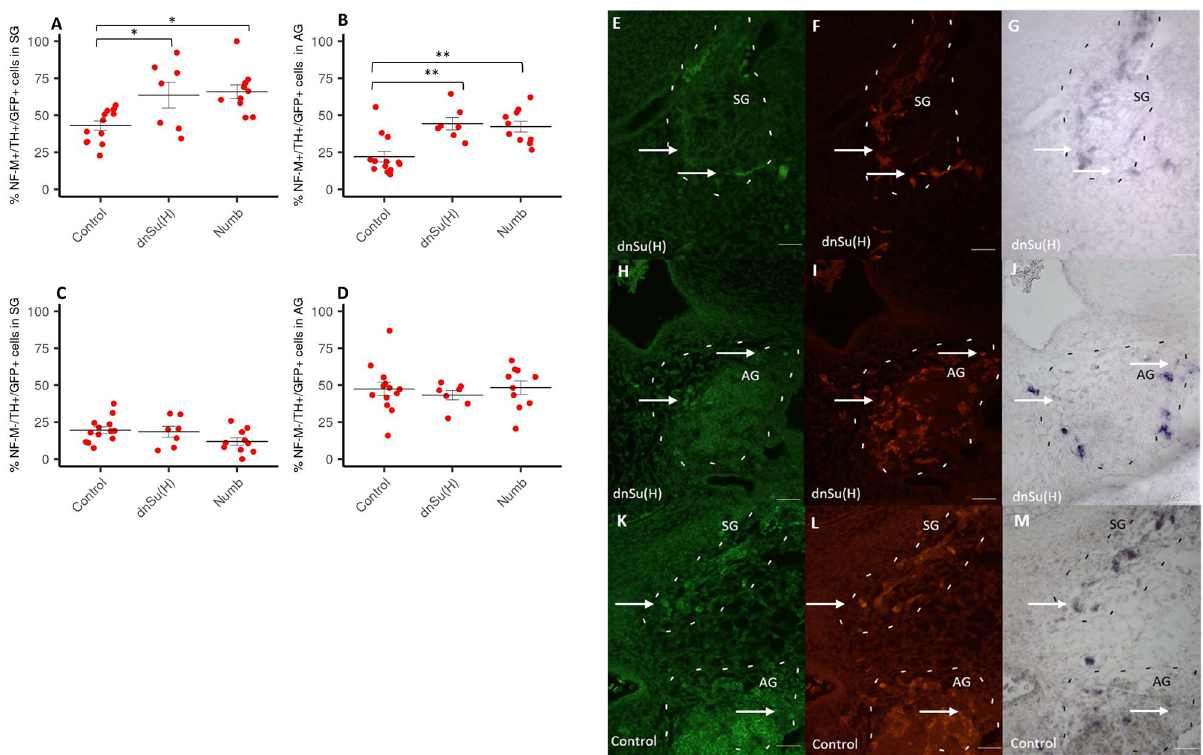
Fig 3. Analysis of neuronal and nonneuronal cells in SG and AG following downregulation of Notch. Amount of NF-M+/TH+/GFP+ cells in SG (A) and AG (B), and amount of NF-M-/TH+/GFP+ cells in SG (C) and AG (D) of E6 chick embryos after electroporation with dnSu(H) or Numb at E2 (control n = 13, dnSu(H) n = 7, Numb n = 10). Data are presented as mean +/- S.EM. and expressed as percentage of the total number GFP+ cells. � p � 0.05; �� p � 0,01; ��� p � 0,001; n: number of experimental animals. Photomicrographs showing the expression of GFP, TH and NF in sympathetic ganglia (SG) and the adrenal gland (AG) of E6 chick embryos after electroporation with dnSu(H), and control at E2. Embryos electroporated with dnSu (H): SG (E-G) and AG (H-J) using antibodies for GFP (E, H), TH (F, I) and in situ hybridization for NF-M mRNA (G, J). Embryos electroporated with control: SG and AG (K-M) at E6 using antibodies for GFP (K), TH (L) and in situ hybridization for NF-M mRNA (M). The values used to build the graphs in S1 File. Scale bar: 100 μ m.